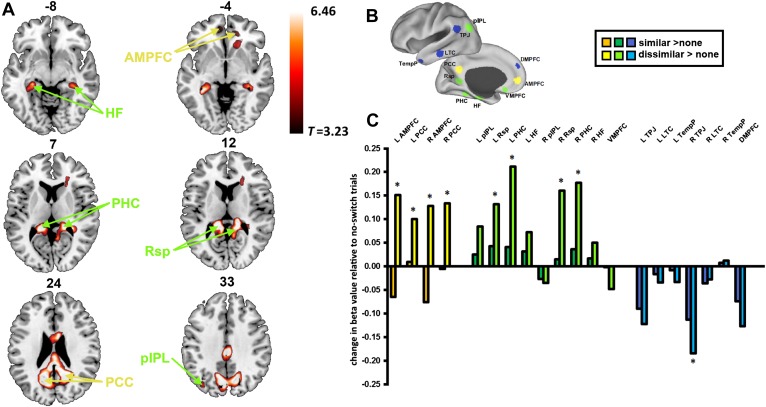
Activation of the default mode network (DMN) for dissimilar task switches.Region labels and regions of interest (ROIs) are color-coded according to the sub-network to which they belong: yellow for Core, green for medial temporal lobe (MTL), blue for dorsomedial prefrontal cortex (DMPFC). (A) Whole brain rendering in axial slices: the numbers above each slice indicate z-coordinate of that slice. The contrast of dissimilar-task-switch > no-switch (T = 3.23, p < 0.05, FDR corrected) shows activations in regions previously identified as the DMN. (B) Locations of DMN ROIs distinguished by Andrews-Hanna et al. (C) Change in activation of similar-task-switch (darker colours) and dissimilar-task-switch (lighter colours) relative to no-switch trials in the DMN ROIs. APMFC: anterior medial prefrontal cortex, PCC: posterior cingulate cortex, pIPL: posterior inferior parietal lobe, Rsp: retrosplenial cortex, PHC: parahippocampal cortex, HF: hippocampal formation, VMPFC: ventromedial prefrontal cortex, TPJ: temporoparietal junction, LTC: lateral temporal cortex, TempP: temporal pole, DMPFC: dorsomedial prefrontal cortex. * indicates p < 0.05.